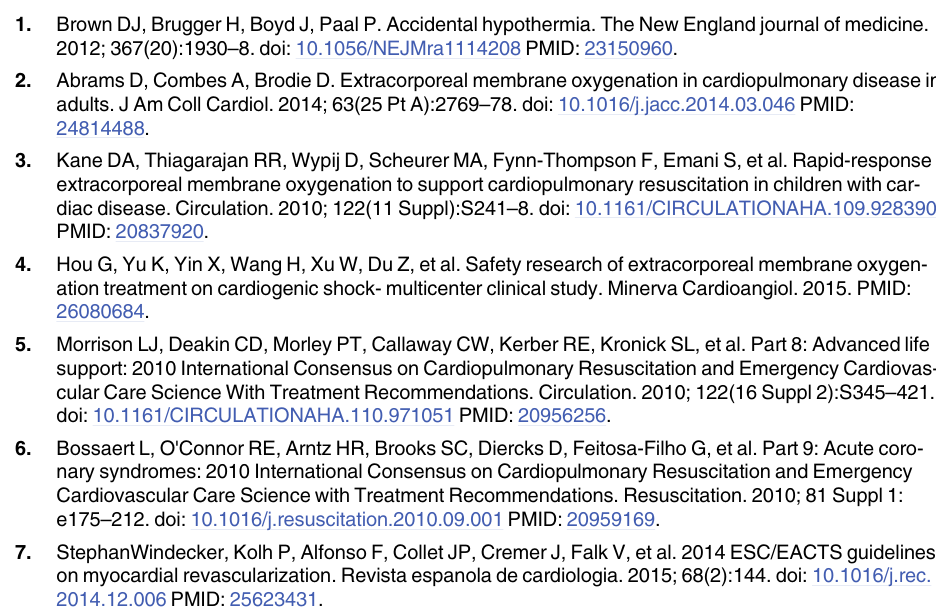
S1 Table. Impact of different P2Y12 inhibitors. Characteristics and outcome of patients on VA-ECMO by different P2Y12 inhibitors or glycoprotein IIb/IIIa blockage. Data is given as number of patients (percentage of all patients in group) or as mean ± SEM, where applicable. Significance is calculated using ANOVA or Chi 2 as applicable. CAD — coronary artery